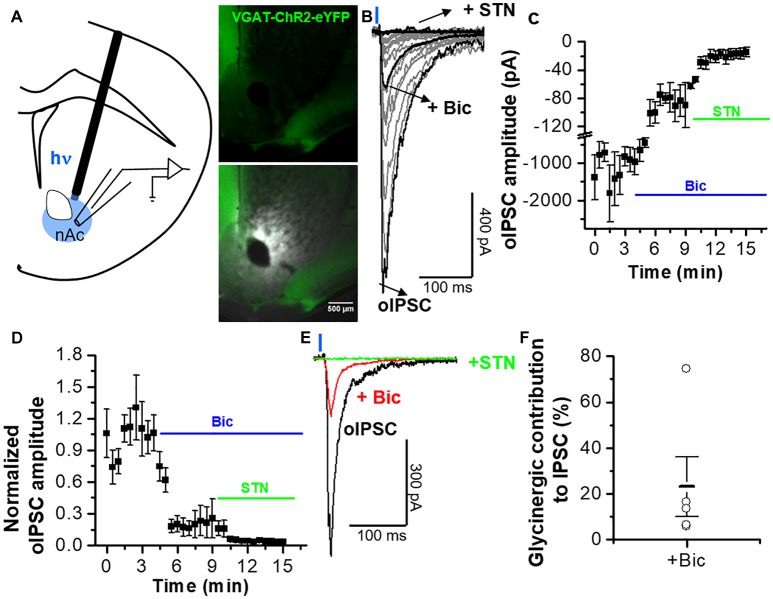
Optogenetically activated inhibitory synaptic transmission in MSNs from nAc. (A) Schematic illustrating oIPSCs recording evoked by 1-ms, 473-nm light focal stimulation. Distribution of vGAT-ChR2-eYFP expression observed in coronal brain slice. (B) Average oIPSC traces per cell (gray) of five neurons from vGAT-ChR2-eYFP mice. Black traces represent the average oIPSC for total, plus 10 μM bicuculline, and plus bicuculline/STN. (C) Graph represents average of IPSC amplitudes during the application of bicuculline and STN. (D) Time course of the oIPSCs with a combination of bicuculline (10 μM) and STN (1 μM) applied at 4 and 9 min, respectively, after the recording started. (E) Average traces of control conditions (black), during application of bicuculline (red), and in the combined presence of STN and bicuculline (green) showing the difference in the amplitude and decay kinetics of the GABAergic and glycinergic IPSC components. (F) Open circles represent the glycinergic IPSC component in individual cells, indicating an average contribution of GlyR-mediated inhibitory current of 23 ± 13% to the oIPSC. The data are mean ± SEM, n = 5.